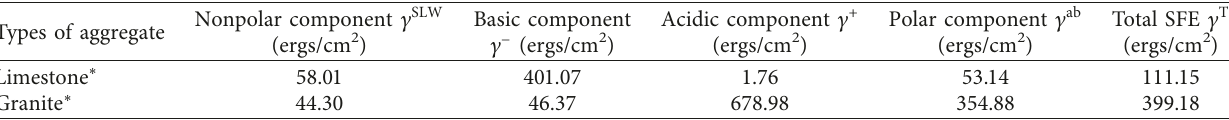
Table 4: Surface free energy characteristics of